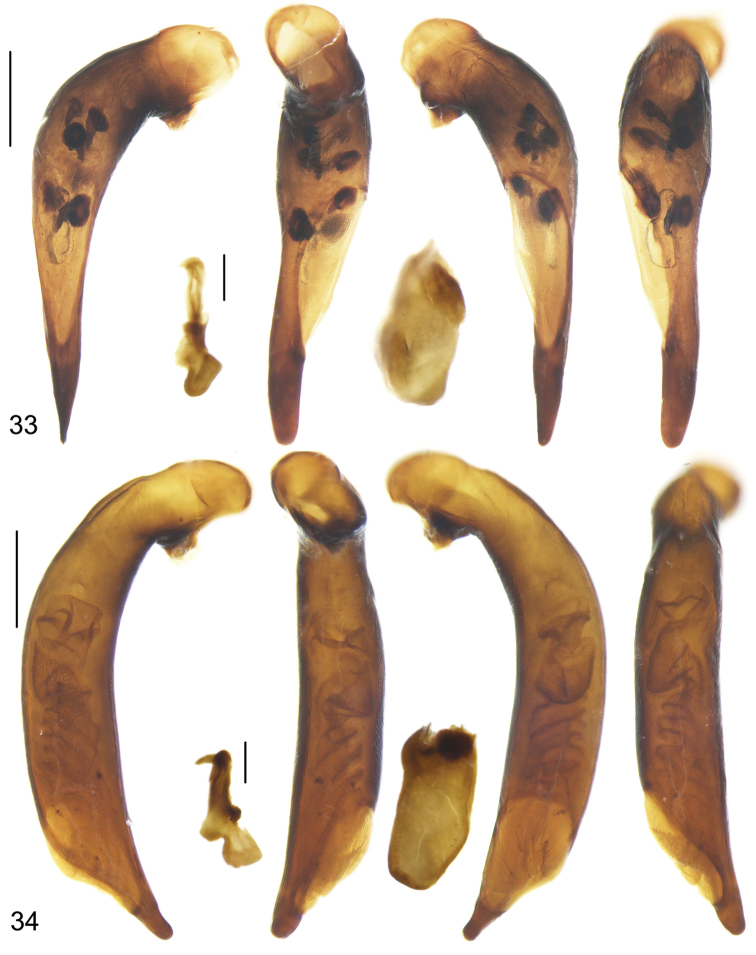
Aedeagus: right-lateral, ventral, left-lateral, and dorsal views of median lobe, scale bars 0.5 mm. Right and left parameres, scale bars 0.2 mm. 33
P.
gibbosus sp. n., holotype, Myanmar (Putao) 34
P.
elegans sp. n., holotype, Xizang (Mêdog).